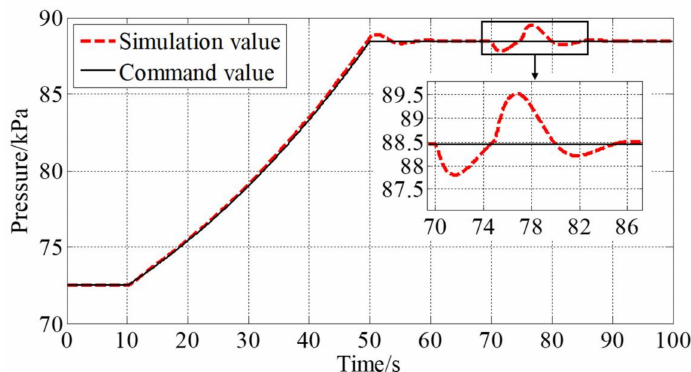
Figure 23. Pressure change of outlet air flow.